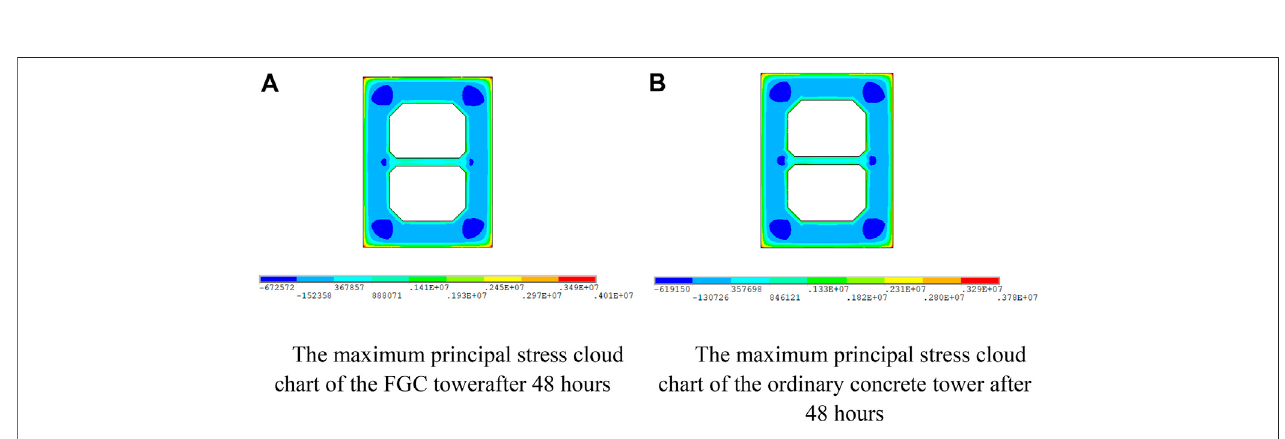
FIGURE11| Themaximumprincipalstresscloudchartunderthehydrationheat. (A) ThemaximumprincipalstresscloudchartoftheFGCtowerafter48 h. (B) The maximum principal stress cloud chart of the ordinary concrete tower after 48 h.